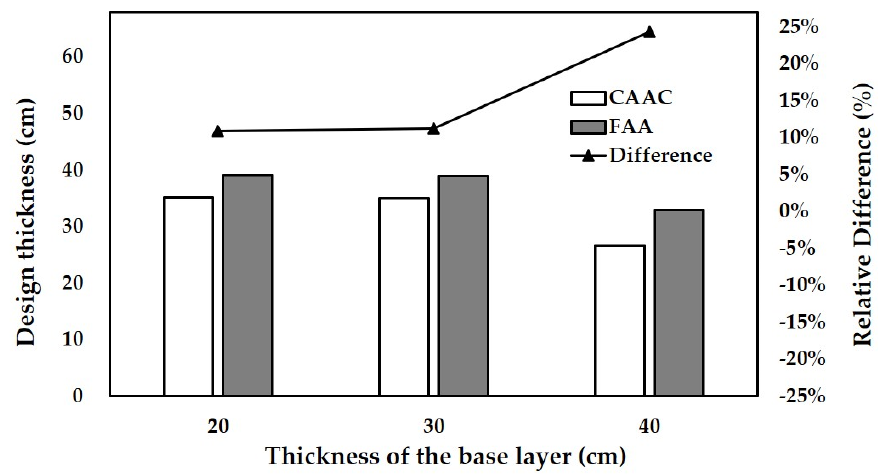
Figure 10. Designed thickness of concrete slabs for different thicknesses of the base layer.